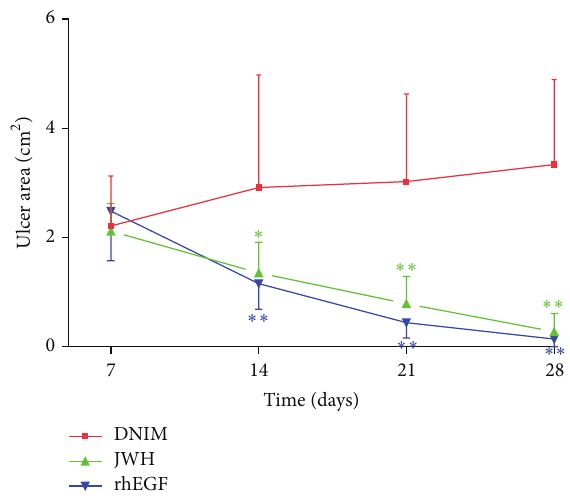
Figure 4: Changes of ulcer area at different times: ulcer areas were indicated with mean ± standard deviation ( 𝑥 ± 𝑆 , 𝑛 = 10 ). The JWH and rhEGF groups showed that the ulcer area decreased over time (at days 14, 21, and 28). The DNIM group showed the ulcer area increased over time (at days 14, 21, and 28). ∗ 𝑃 < 0.05 versus DNIM group; ∗∗ 𝑃 < 0.001 versus DNIM